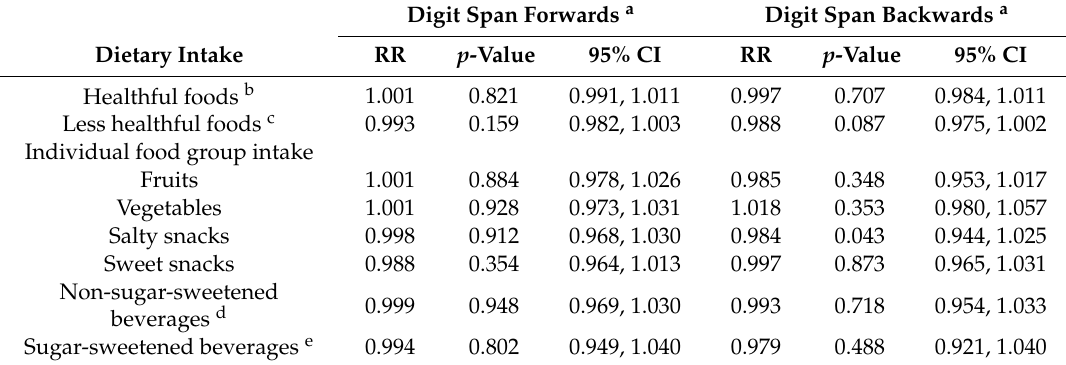
Table 3. Multiple Poisson regression models predicting the Digit Span scores by intake of food and beverage and combined food group servings in the FLEX study population ( n = 868).